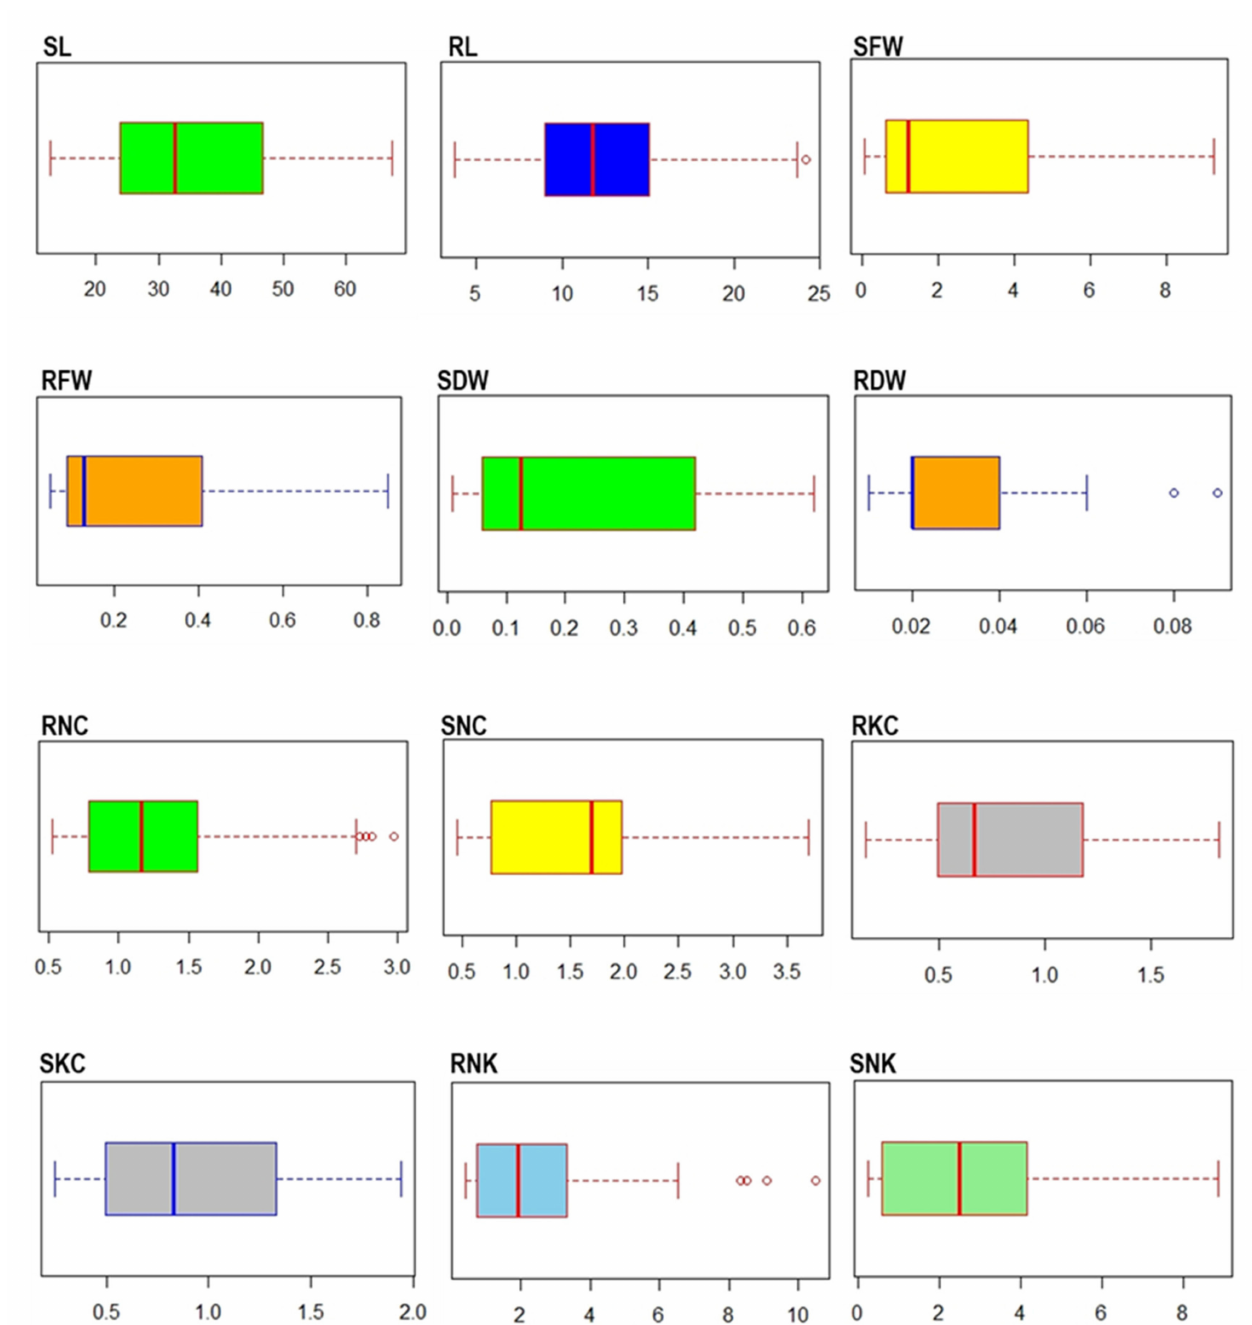
Figure 1. Variation in rice germplasm for traits associated with seedling stage salinity tolerance. SL, shoot length (cm); RL, root length (cm); SFW, shoot fresh weight (g); RFW, root fresh weight (g); SDW, shoot dry weight (g); RDW, root dry weight (g); RNC, root Na + content (mmol/g); SNC, shoot Na + content (mmol/g); RKC, root K + content (mmol/g); SKC, shoot K + content (mmol/g); RNK, root Na + /K + ratio; SNK, shoot Na + /K +